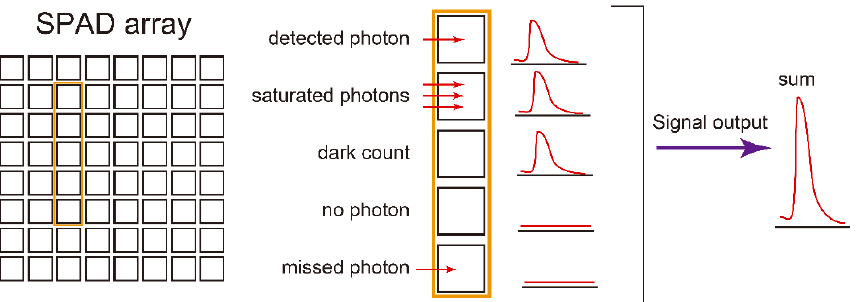
Figure 17. Schematic of the operating principle of silicon photomultipliers (SiPMs): SiPMs consist a SPAD array and every SPAD acts as an element that generates an all-or-nothing current pulse. When one or more photons are absorbed, a current pulse is generated. A current pulse is also produced by the dark count, whereas a current pulse is not generated when photon absorption fails. The output is the sum of the SPADs. Adapted with permission from [38] © The Optical Society.